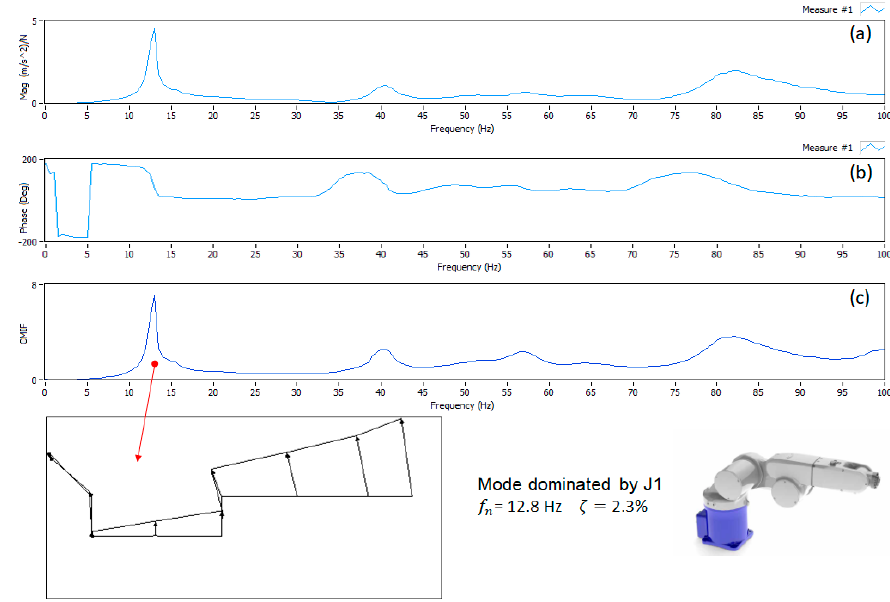
Figure 7. Test 1 configuration, ( a ) direct point frequency response function (FRF) modulus, ( b ) phase, ( c ) complex mode indicator function (CMIF).